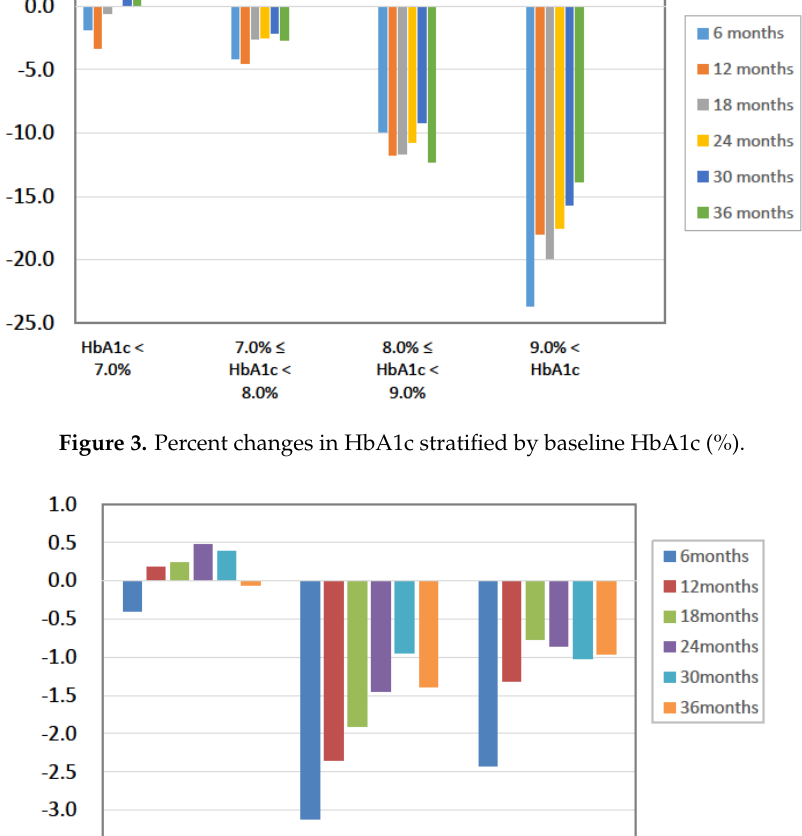
Figure 4. Absolute changes in body weight stratified by baseline BMI (kg).